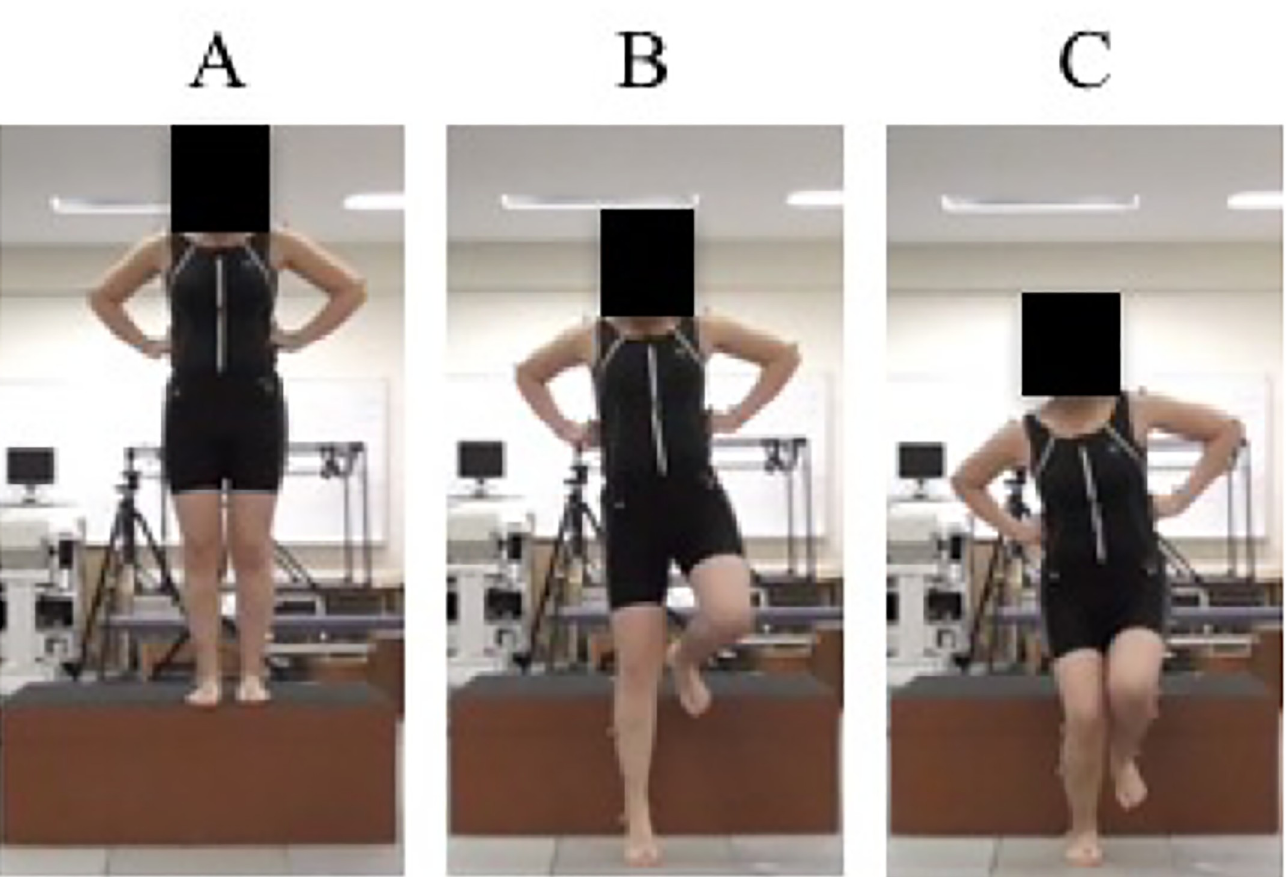
Fig 1. Each landing phase of single leg drop landing. (A) Single leg drop landing. Start position standing on a 40-cm box. (B) Initial contact on the dominant leg. (C)Subjects maintain the landing